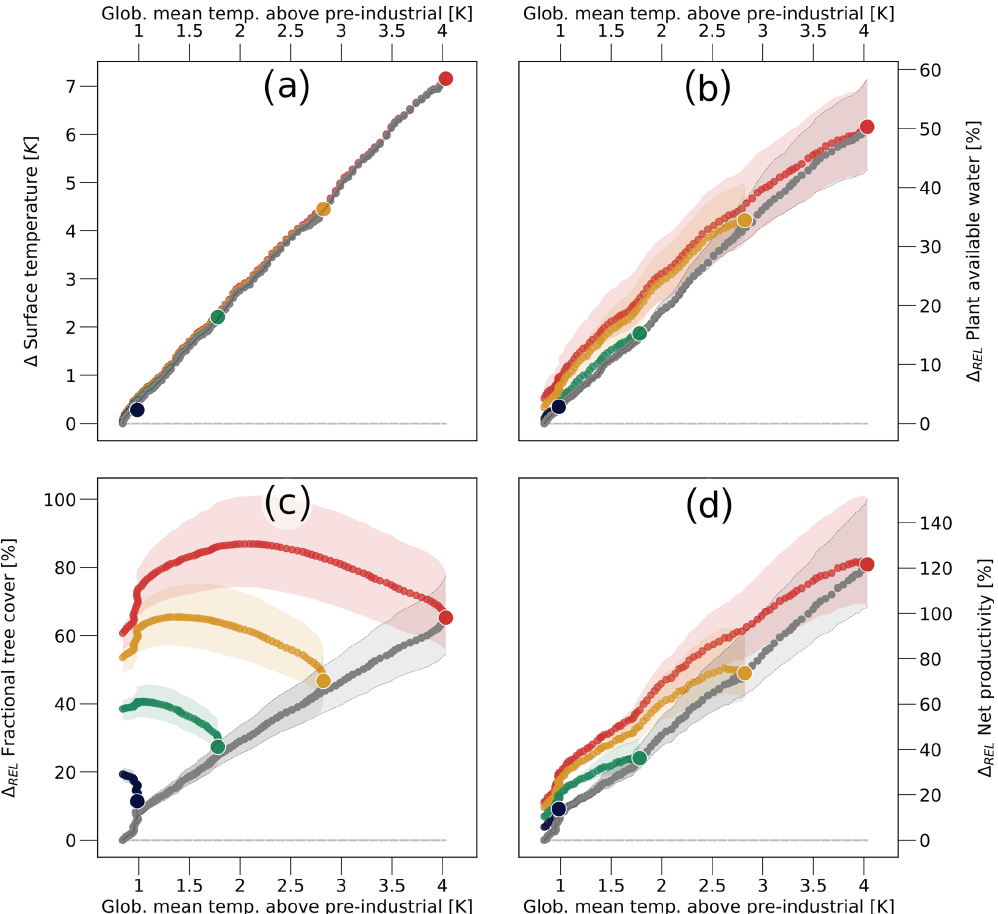
Figure 8. Drivers of soil carbon inputs. (a) Change in mean surface temperature. Relative change in (b) plant-available water, (c) tree cover and (d) net primary productivity. All panels pertain to regions with permafrost-affected soils. Colours and symbols have the same meaning as in Fig.